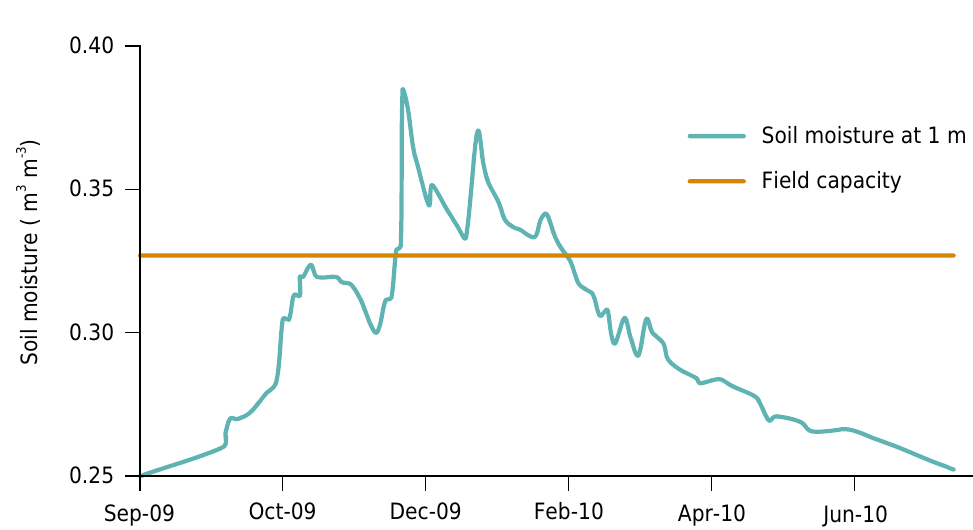
Figure 5. Soil moisture and water content at field capacity (FC) at a depth of 1 m in the agroforestry system. The area above the red line corresponds to the total volume of recharge (water per volume of